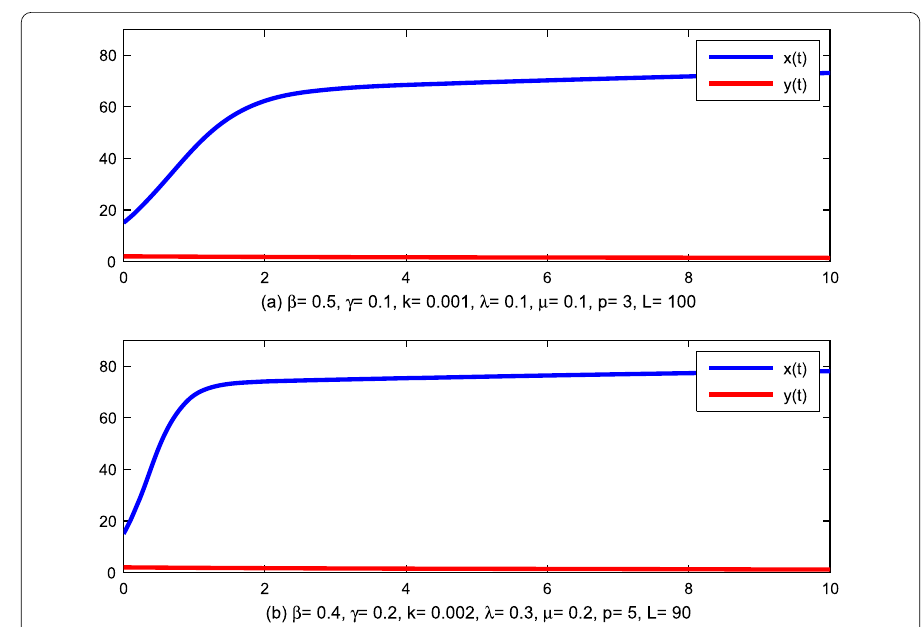
Figure 3 The curves of x ( t ) and y ( t ) at different values of the parameters and at the initial point x (0) = 15, y (0) = 2